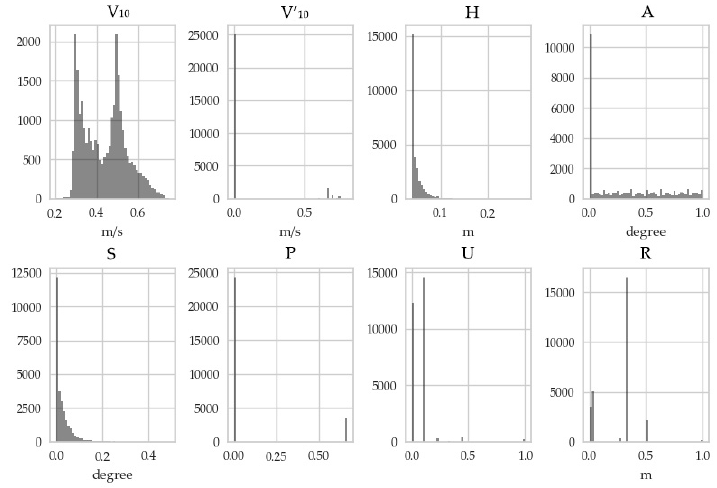
Figure 8. Distribution of the target side data.